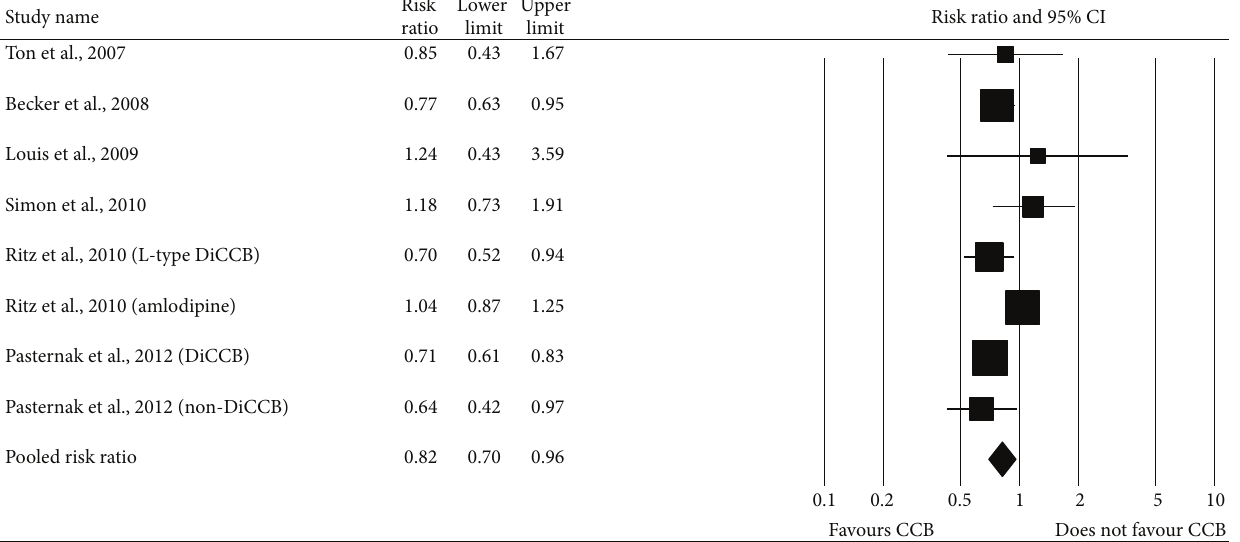
Figure 2: Combined estimate of risk ratio and 95% confidence intervals of Parkinson’s disease associated with calcium channel blockers use based on six studies (three case-control and three cohort) of 27,67,990 subjects including 11,941 PD cases. Squares indicate RR in each study. The square size is proportional to the weight of the corresponding study in the meta-analysis; the length of horizontal lines represents the 95% CI. The shaded diamond indicates the combined RR and 95% CI (random-effects